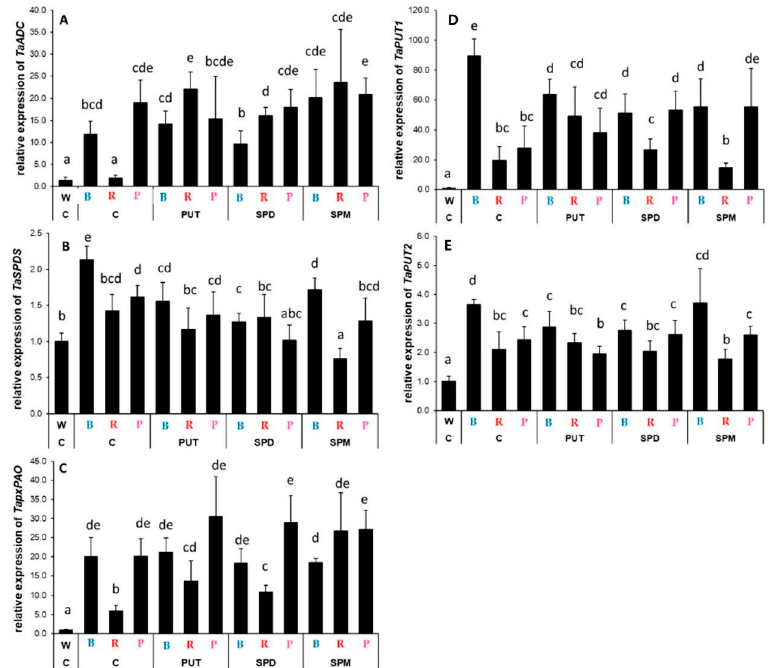
Figure 8. Gene expression patterns of arginine decarboxylase (( A ): ADC ), spermidine synthase (( B ): SPDS ), peroxisomal polyamine oxidase (( C ): pxPAO ) and polyamine uptake transporter genes (( D ): PUT1 and ( E ): PUT2 ) in the leaves of plants grown under different light regimes (white light: W, blue light: B, red + far-red: R and the combination of blue and red + far-red, pink: P) treated with or without polyamines (control: C, putrescine: PUT, spermidine: SPD and spermine: SPM). Values are means ± SD. All reactions for gene expression analyses were performed in triplicate using 3 biological and 3 technical repetitions. Different letters indicate statistically significant differences at p < 0.05 level, using Duncan’s post hoc